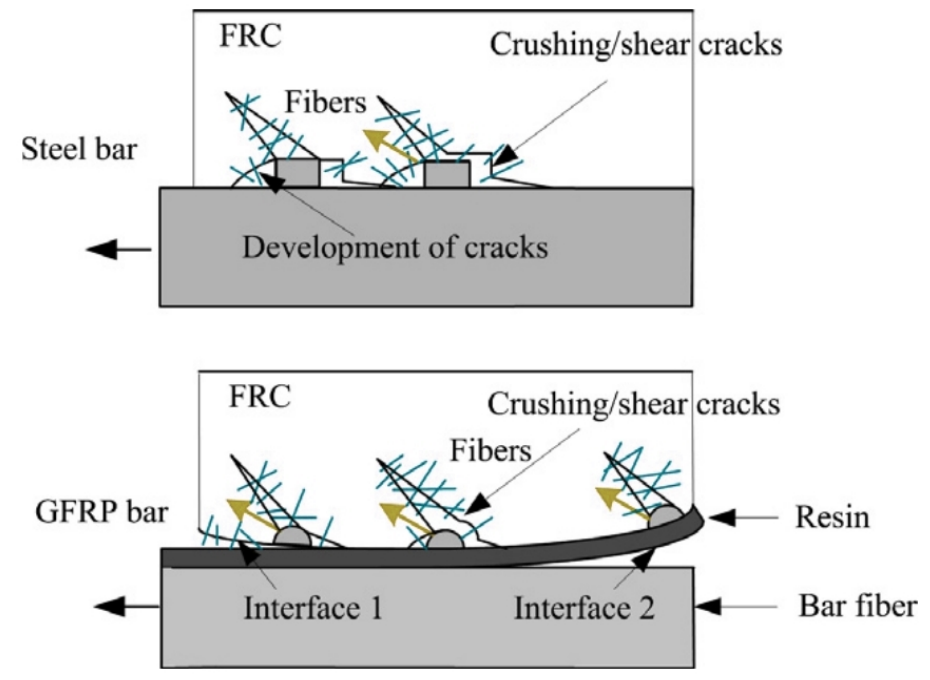
Figure 10. Effect of fibers on concrete cracks [97]. Table 8. Studies on the influence of concrete type on FRP–concrete bond